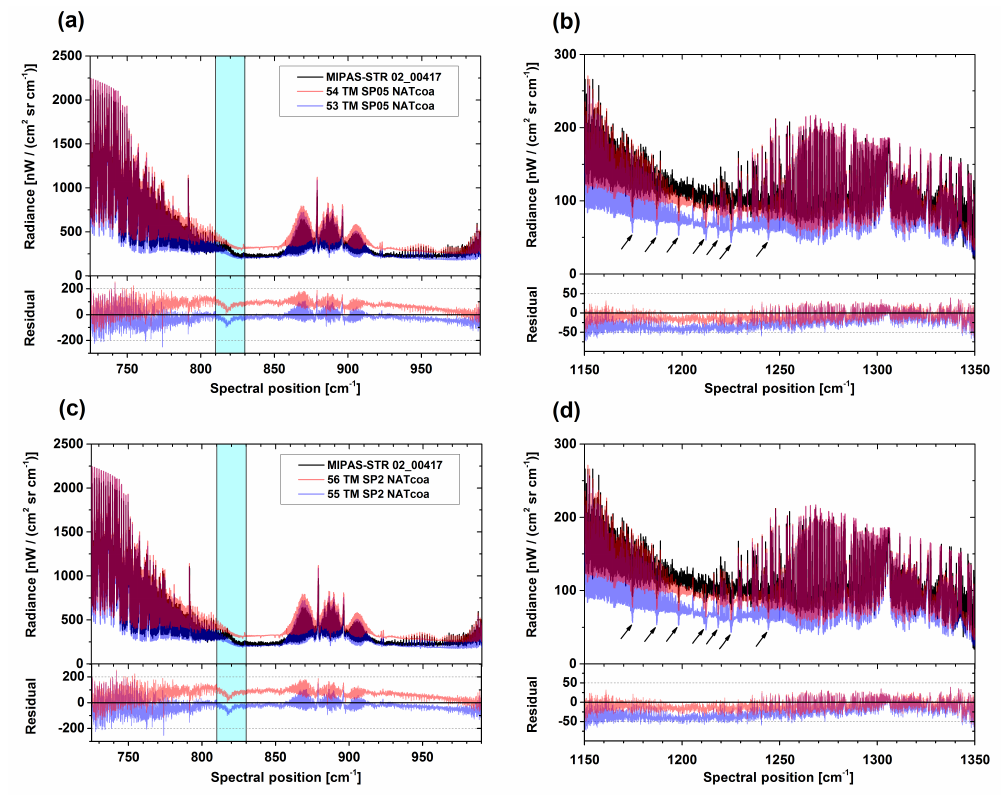
Figure 11. T-Matrix calculations for moderately aspherical β -NAT particles. Black spectra in all panels: MIPAS-STR limb observation (13:47UTC, tangent altitude 18.4km). Simulations of β -NAT with (a, b) AR = 0.5 and (c, d) AR = 2.0 with size distributions A (red) and B (blue). Lower panels: residuals between the simulations and the observation. Black arrows denote prominent H 2 O absorption signatures from scattering of tropospheric radiation by PSC particles. Numbers in the legend refer to scenarios in Table 1. “NATcoa” corresponds to β -NAT, “TM” to T-matrix simulation, and “SP” to spheroid (numbers indicate